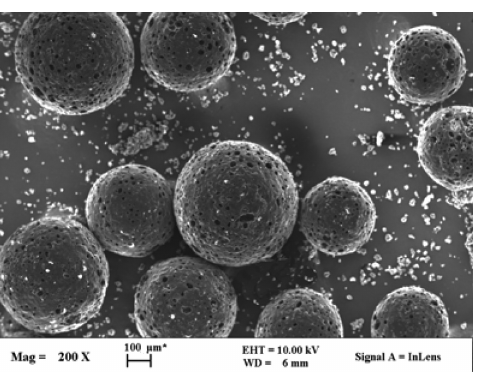
Figure 5 Morphology of the 40 wt.% CNTs/AC composite spheres.